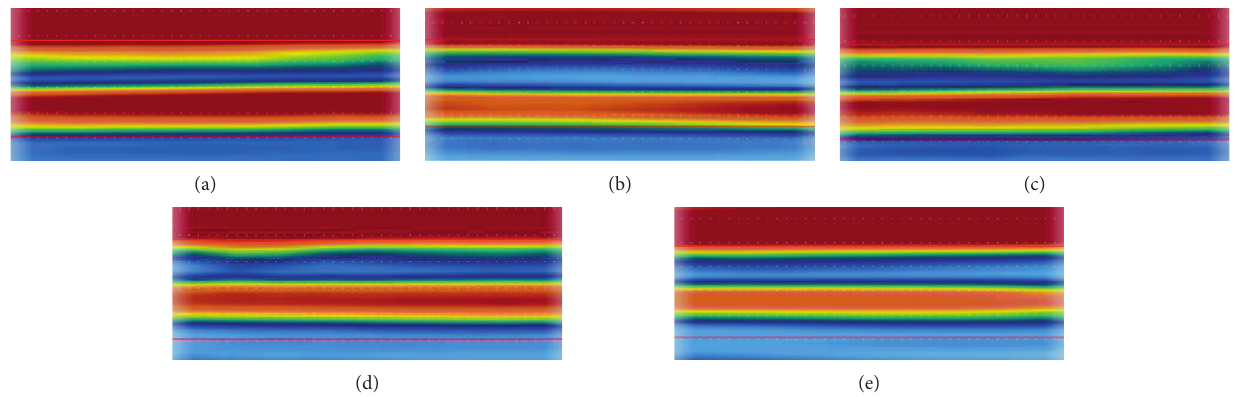
Figure 14: Results of ultrasonic scanning of testing samples before tensile experiments. (a) Scanning spot 1. (b) Scanning spot 2. (c) Scanning spot 3. (d) Scanning spot 4. (e) Scanning spot 5.